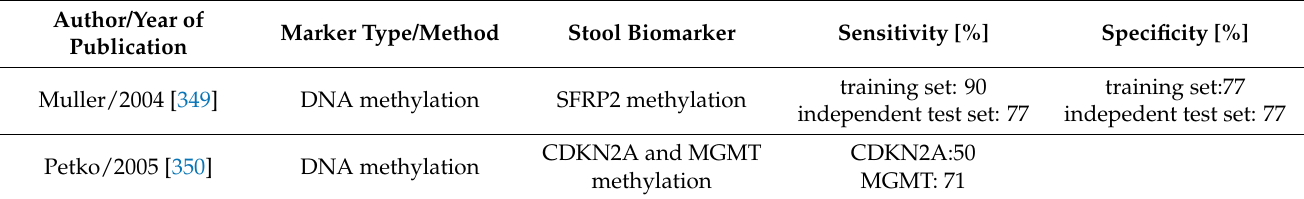
Table 7. According to Loktionov in modification: non-invasive, methylated DNA stool biomarkers used in colorectal cancer detection